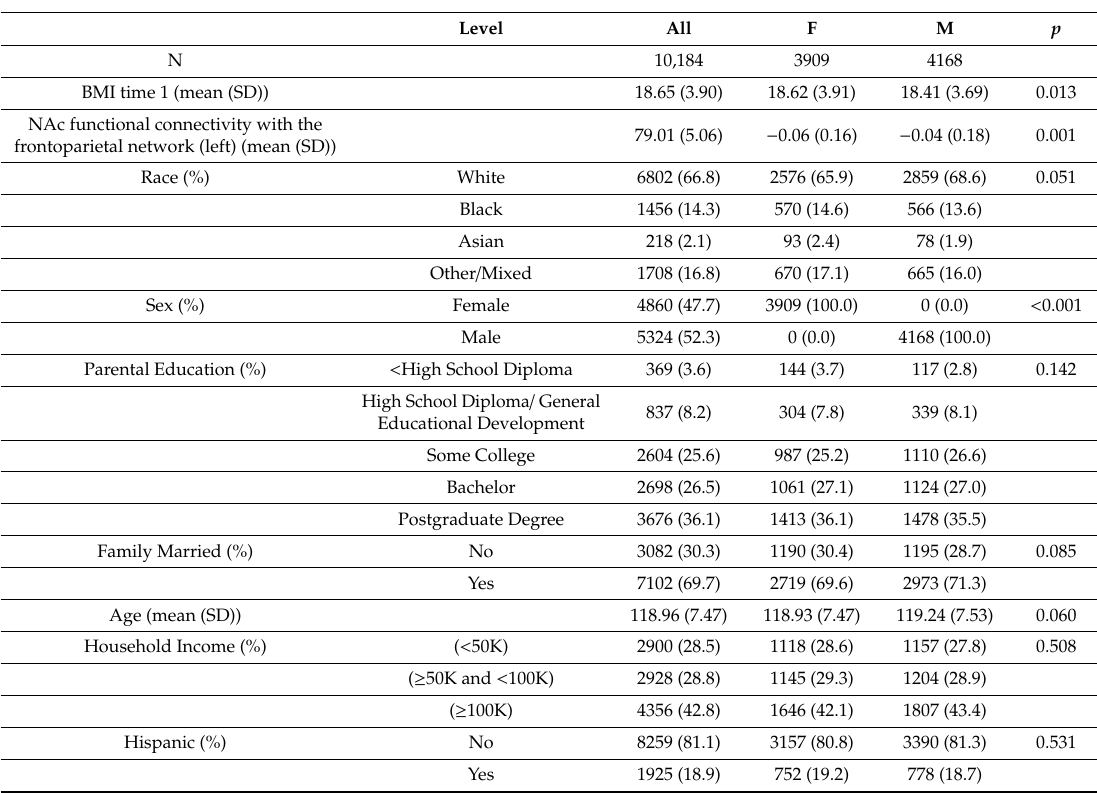
Table A2. Distribution of study variables based on sex.